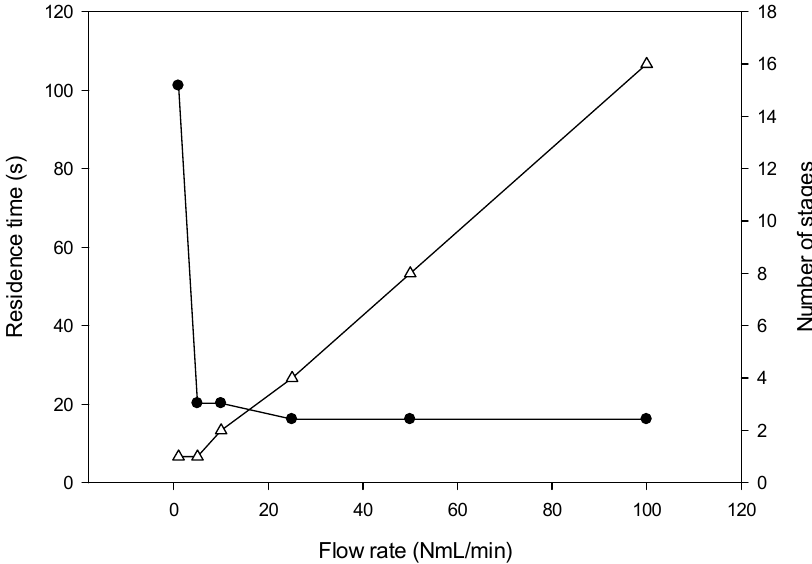
Figure 7. Number of stages ( ∆ ) required for the oscillations of the scalar value at the micromixer’s exit to be lower than 5% of the targeted value 0.1 at flow rates ranging from 1 to 100 NmL·min − 1 . Variations of the residence time ( • ) with the flow rate for the corresponding number of stages required. At 100 NmL·min − 1 , the 5% threshold is not reached: the percentage of oscillations is 6.1% after the 16th stage of mixing.